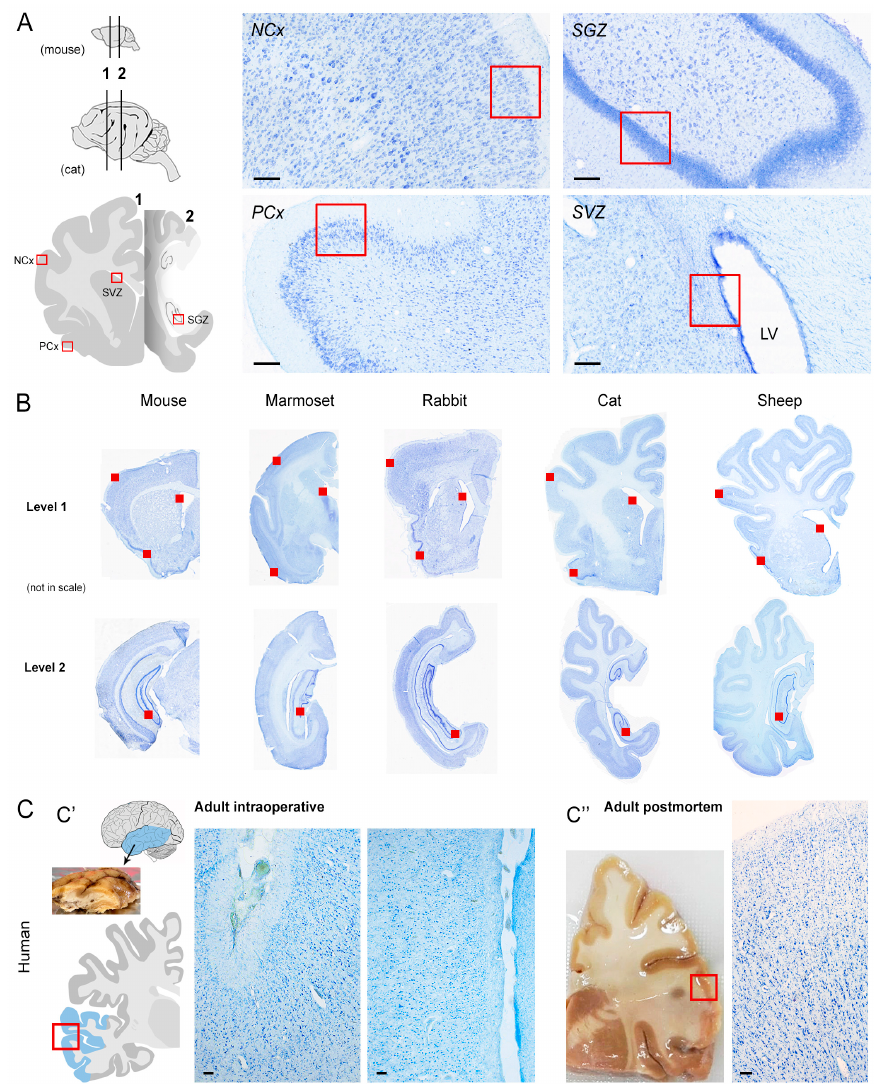
Figure 3. Anatomy of the brain regions studied. ( A ) Four different regions were considered (SVZ, subventricular zone; SGZ, sub-granular zone of the hippocampal dentate gyrus; NCx, neocortex; PCx, paleocortex; indicated by red boxes in ( A , C ), and red squares in ( B )) at two different anterior–posterior, coronal levels (level 1: crossing the SVZ; level 2: crossing the hippocampus) in five mammalian species. ( B ) Whole coronal sections cut at the two brain levels, stained with toluidine blue and scanned with slidescanner Axioscan (Zaiss; Oberkochen, Germany). ( C ) Human brain tissues were obtained from intraoperative ( C (cid:48) ) and post-mortem ( C” ) specimens corresponding to the temporal lobe (light blue). Scale bars: ( A , C ), 100 µ